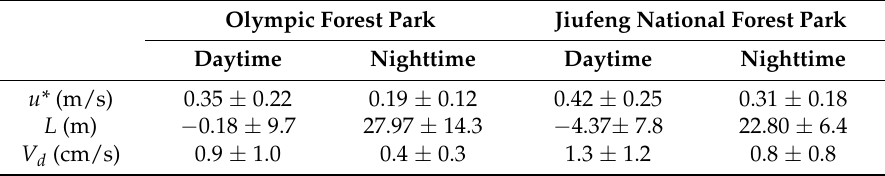
Table 2. Mean deposition velocities V d , friction velocity u* and Monine-Obukhov length L in the daytime (6:00 a.m.–18:00 p.m.) and nighttime (18:00 p.m.–6:00 a.m., morrow) during the study period (May 2013). All of the values are the mean ± standard